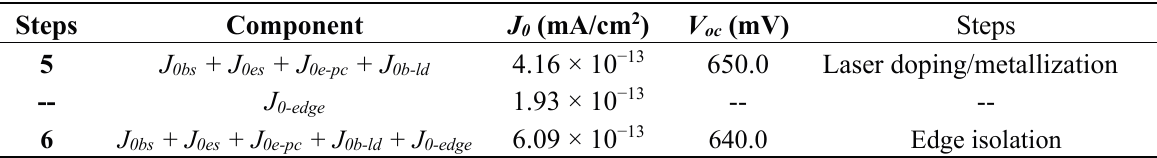
current density introduced by edge